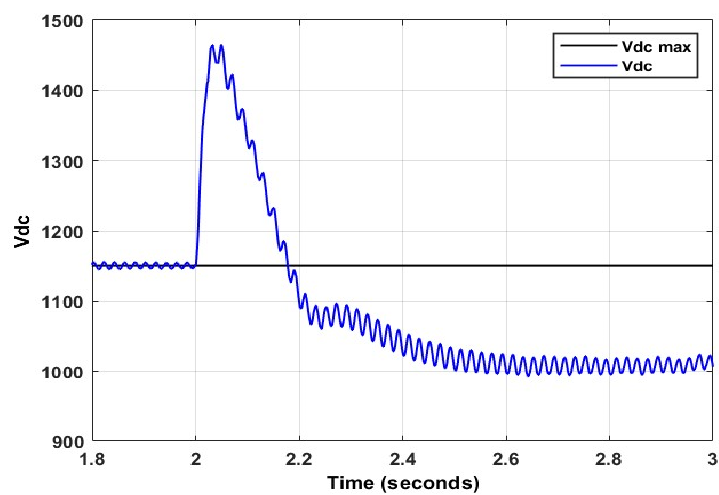
Figure 12. DC voltage transient using AVOA at 70% dip.